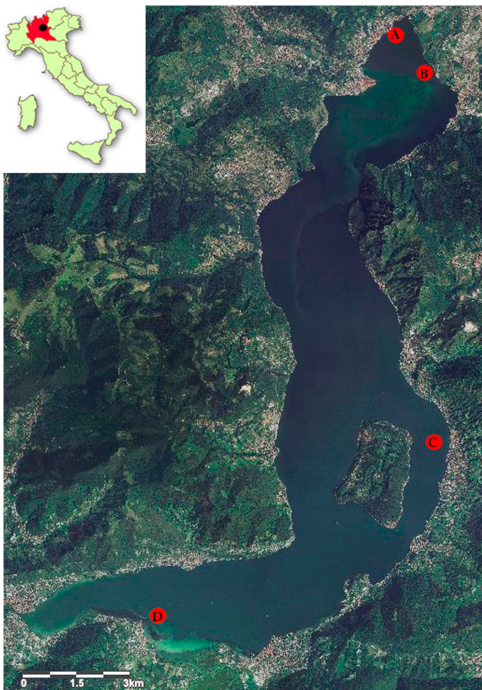
Figure 1. Lake Iseo (Lombardy, Northern Italy) and location of sampling sites (in red). A : Costa Volpino (northern area, 45 ◦ 49 (cid:48) 01.2” N 10 ◦ 05 (cid:48) 18.1” E); B : Pisogne (northern area, 45 ◦ 48 (cid:48) 26.8” N 10 ◦ 04 (cid:48)